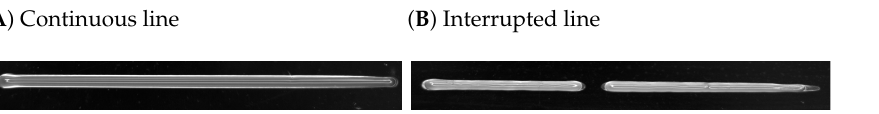
Figure 5. Exemplary raw images of printed lines with bioink A4G3 containing cells. In ( A ), a continuous and, in ( B ), an interrupted line is shown.